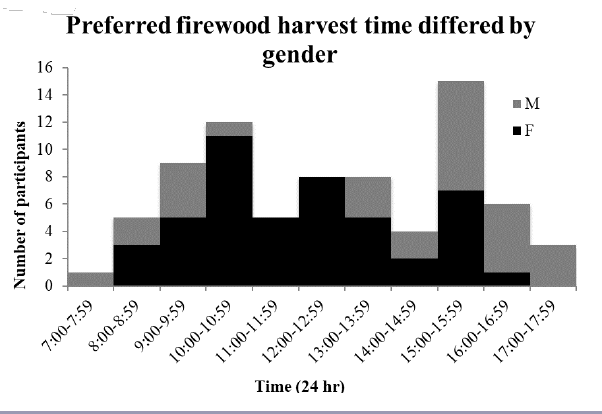
Fig. 3 . There was a significant difference between men (M) and women (F) for preferred firewood harvest times, X² (10, N = 76) = 26.07, p = 0.0036.